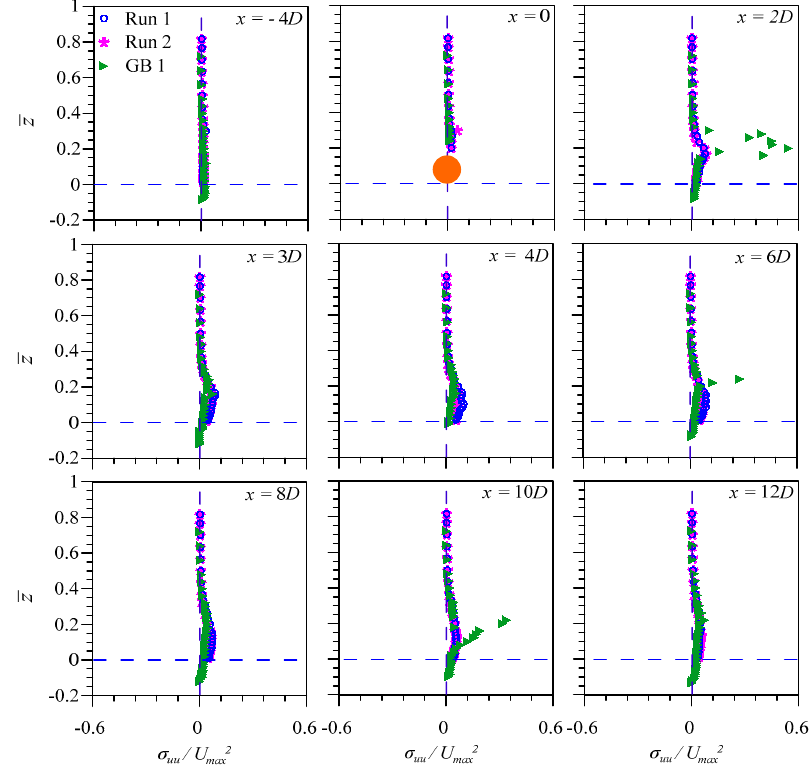
Figure 8. The vertical profiles of normalized longitudinal RNS ( σ uu / U max 2 ) at different measuring stations ( 𝑥 ) for Run 1, Run 2, and GB 1.